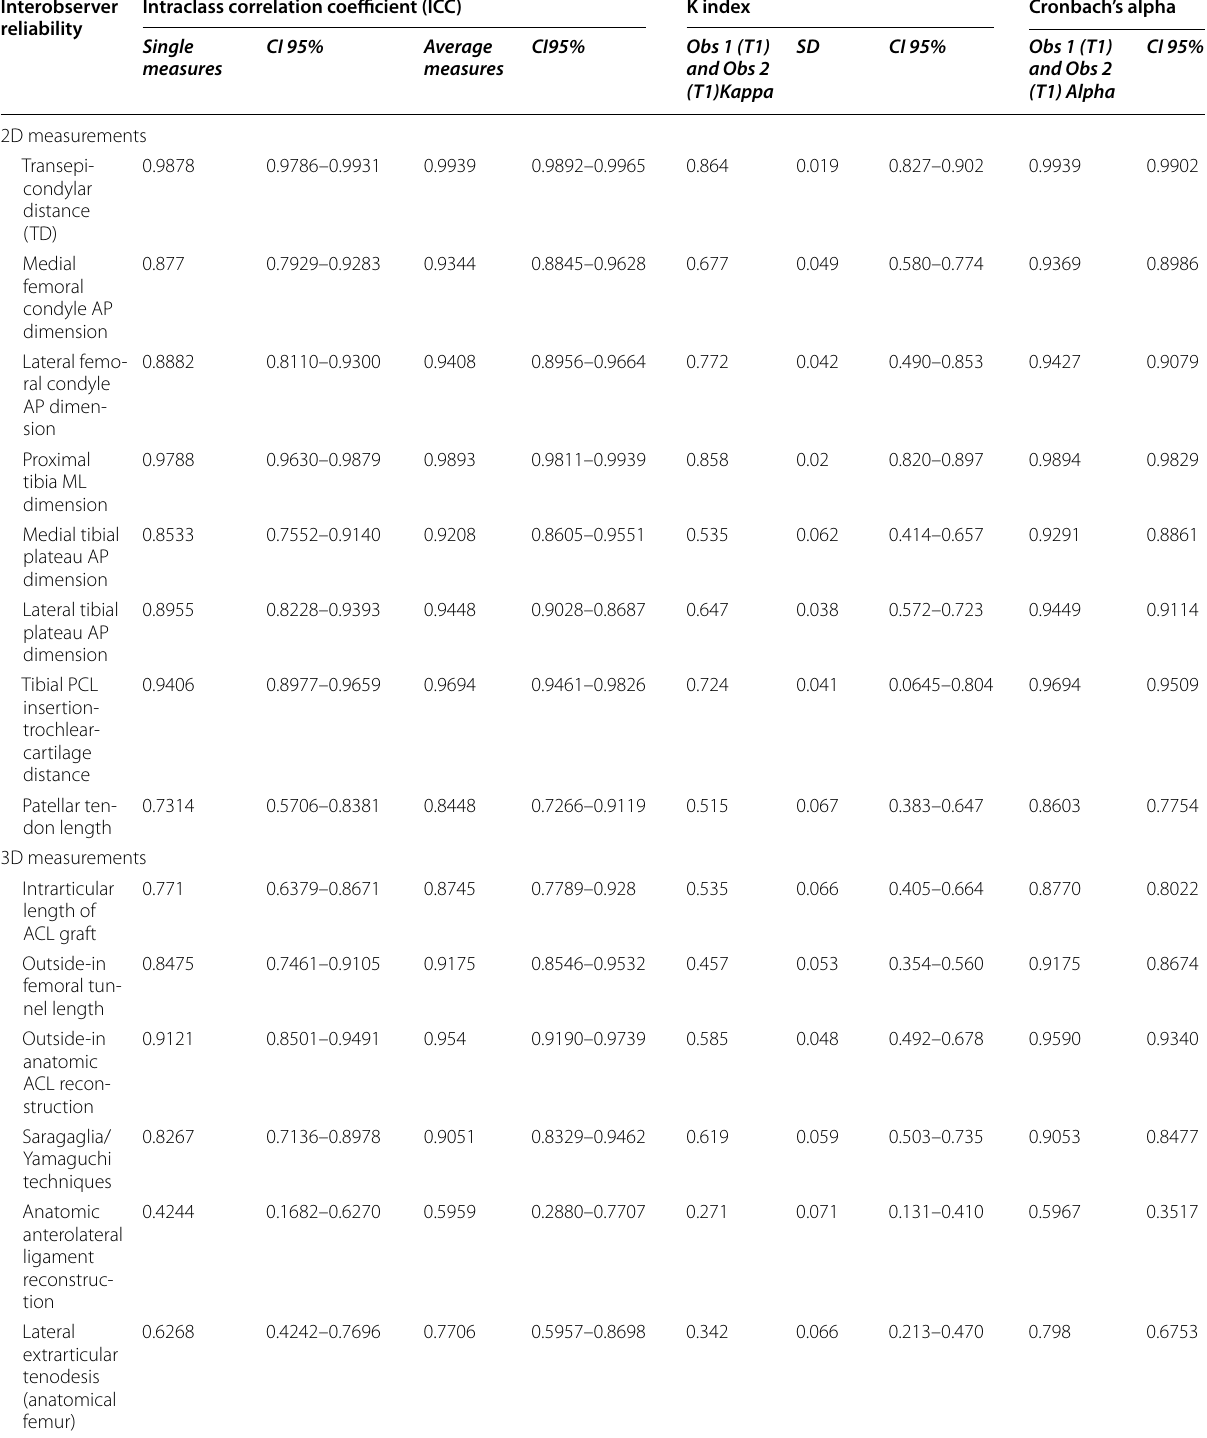
Table 3 Interobserver reliability tested with intraclass correlation coefficient (ICC), Kappa Index, and Cronbach’s alpha for the 2D